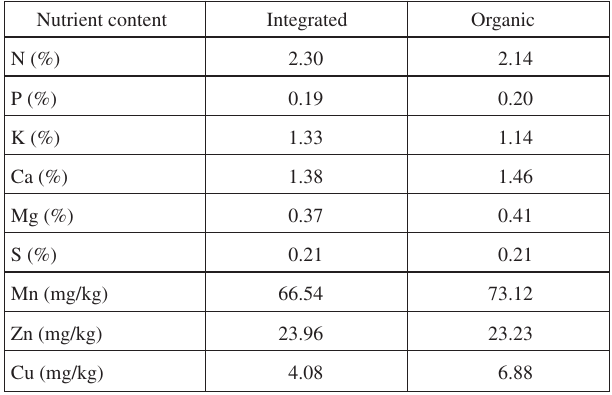
Table 2. Nutrient contents in apple leaves (Pallag, 2002–2004, averages of cultivars at standard sampling time) Nutrient content Integrated Organic